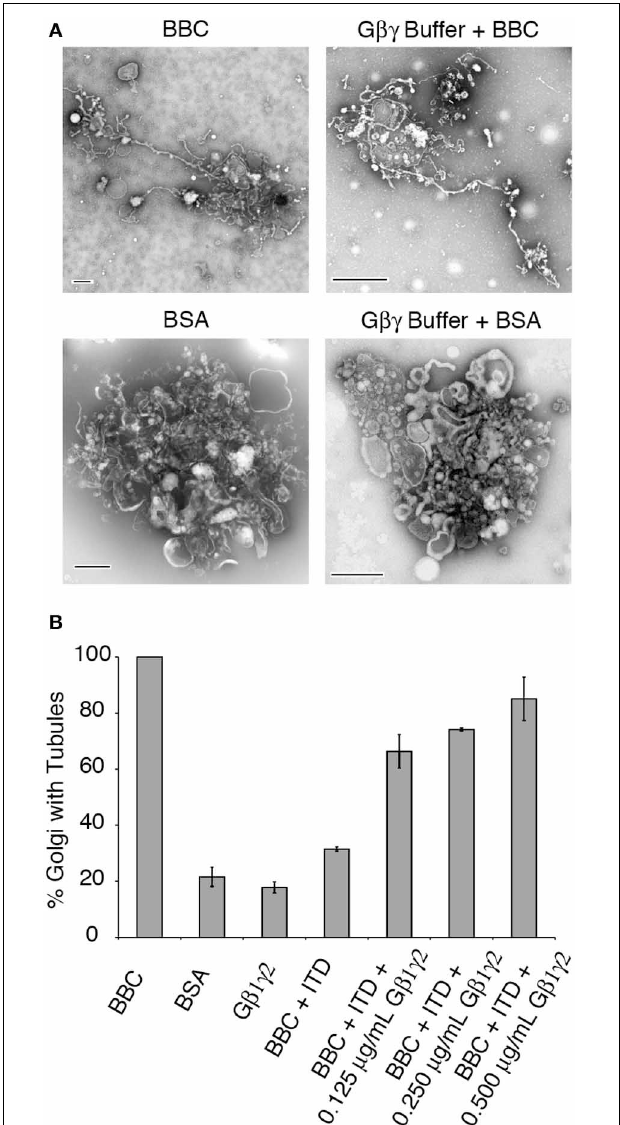
FIGURE 3 | G β 1 γ 2 rescues ITD inhibition of cytosol-stimulated Golgi membrane tubules. (A) Representative EM micrographs of Golgi treated with BBC (1.5mg/ml) or BSA (0.2mg/ml) in the presence or absence of the G βγ buffer that contains CHAPS detergent. Membrane tubules and Golgi morphology were unaffected by the presence of the buffer. (B) Quantification of the fraction of Golgi with tubules, relative to the maximum percent of Golgi with tubules seen with BBC (1.5mg/ml) alone. Final concentrations (after mixing the pre-incubated Golgi and cytosol) are shown for purified G βγ . ITD final concentration was 25 μ M. Error bars = s.e.m. Samples containing BBC + ITD + G β 1 γ 2 were statistically different with p-values < 0.003 compared to BSA, G β 1 γ 2 alone, or BBC + ITD, as determined using